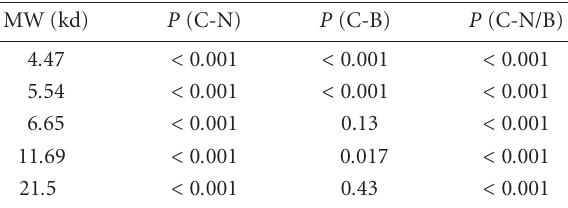
Table 2. Statistical comparison of the intensity levels of the peaks used in the decision tree between the cancer and control groups. C-N: cancer versus normal; C-B: cancer versus benign; and C-B/N: cancer versus normal and benign.